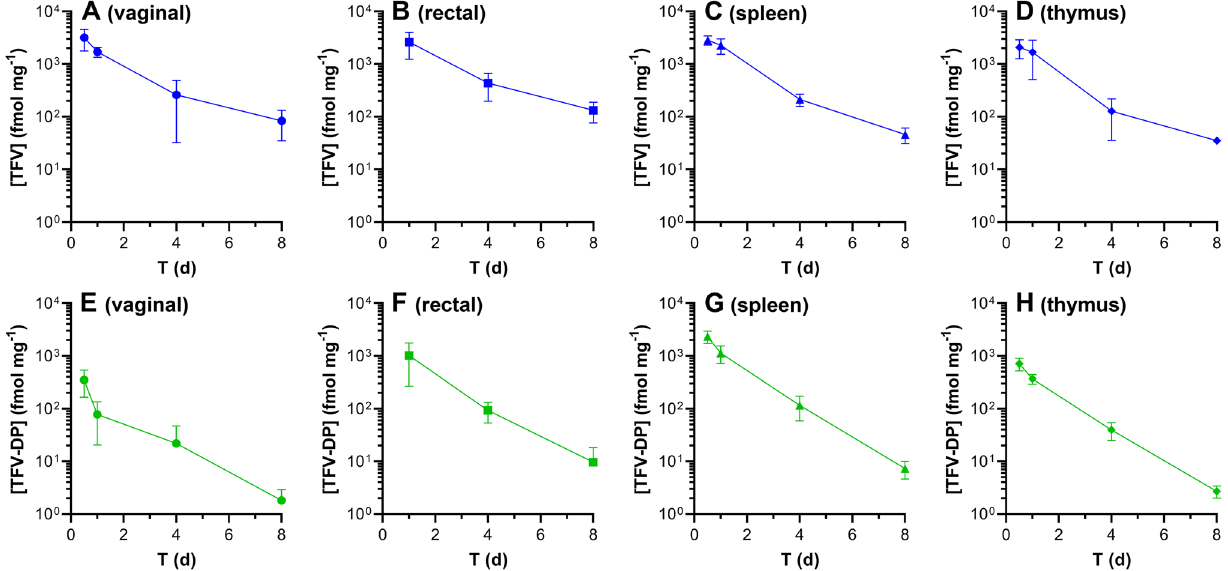
Figure 4. Tissue homogenate drug concentration–time profiles following intravenous TAF dosing in C57BL/6 J mice. Blue, TFV; green, TFV-DP. The sampled anatomic compartments are: ( A ) and ( E ), vaginal (median tissue mass, 192 mg/sample); ( B ) and ( F ) rectal (median tissue mass, 71 mg/sample); ( C ) and ( G ) spleen (median tissue mass, 106 mg/sample); and ( D ) and ( H ) thymus (median tissue mass, 68 mg/sample). The assay LLOQs are: TFV (based on 0.05 ng/sample), vaginal 0.9 fmol mg -1 ; rectal, 2.4 fmol mg -1 ; spleen, 1.6 fmol mg -1 ; thymus, 2.6 fmol mg -1 ; TFV-DP (based on 5 fmol/sample), vaginal 0.03 fmol mg -1 ; rectal, 0.07 fmol mg -1 ; spleen, 0.05 fmol mg -1 ; thymus, 0.07 fmol mg -1